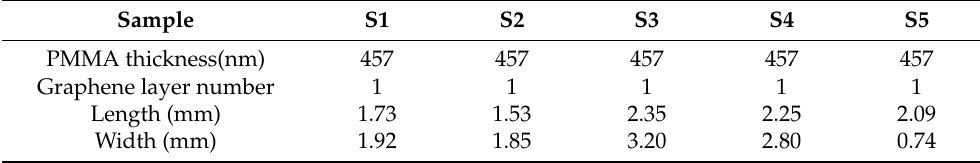
Table 1. PMMA thickness, graphene layer number, length, and width of S1, S2, S3, S4, and